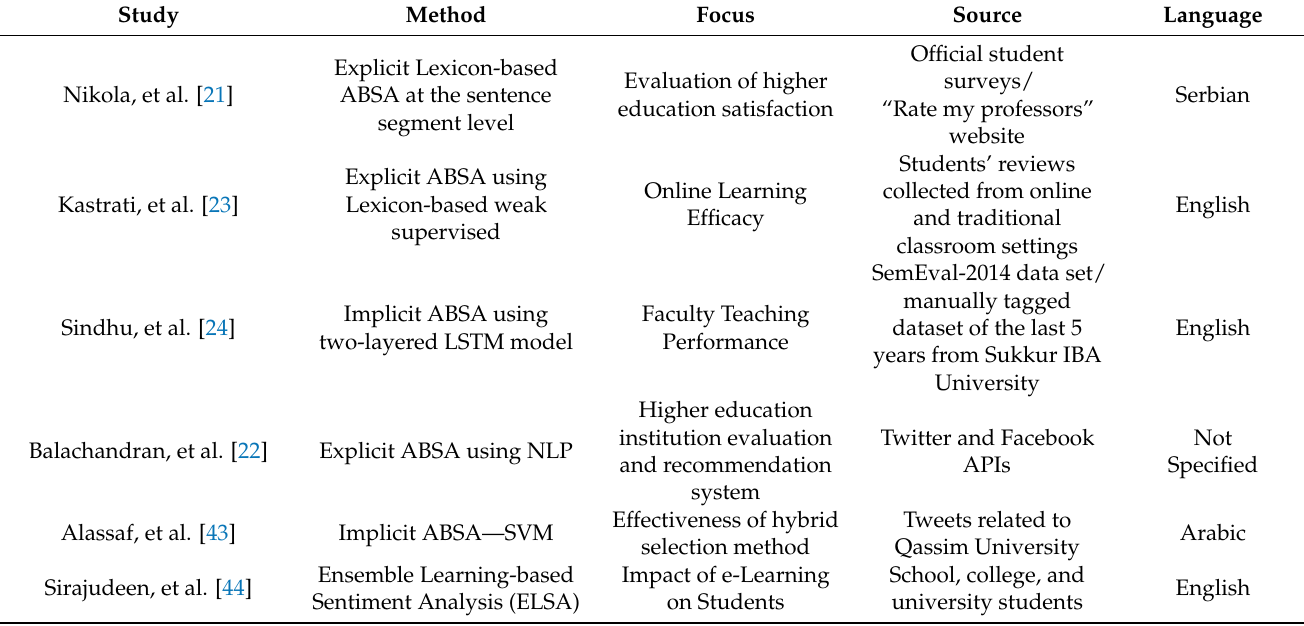
Table 2. Summary of ABSA research studies in the field of